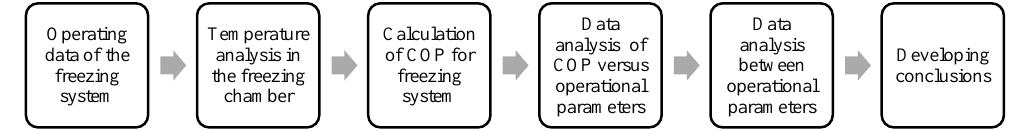
Fig. 1. Algorithm of the freezer electricity consumption